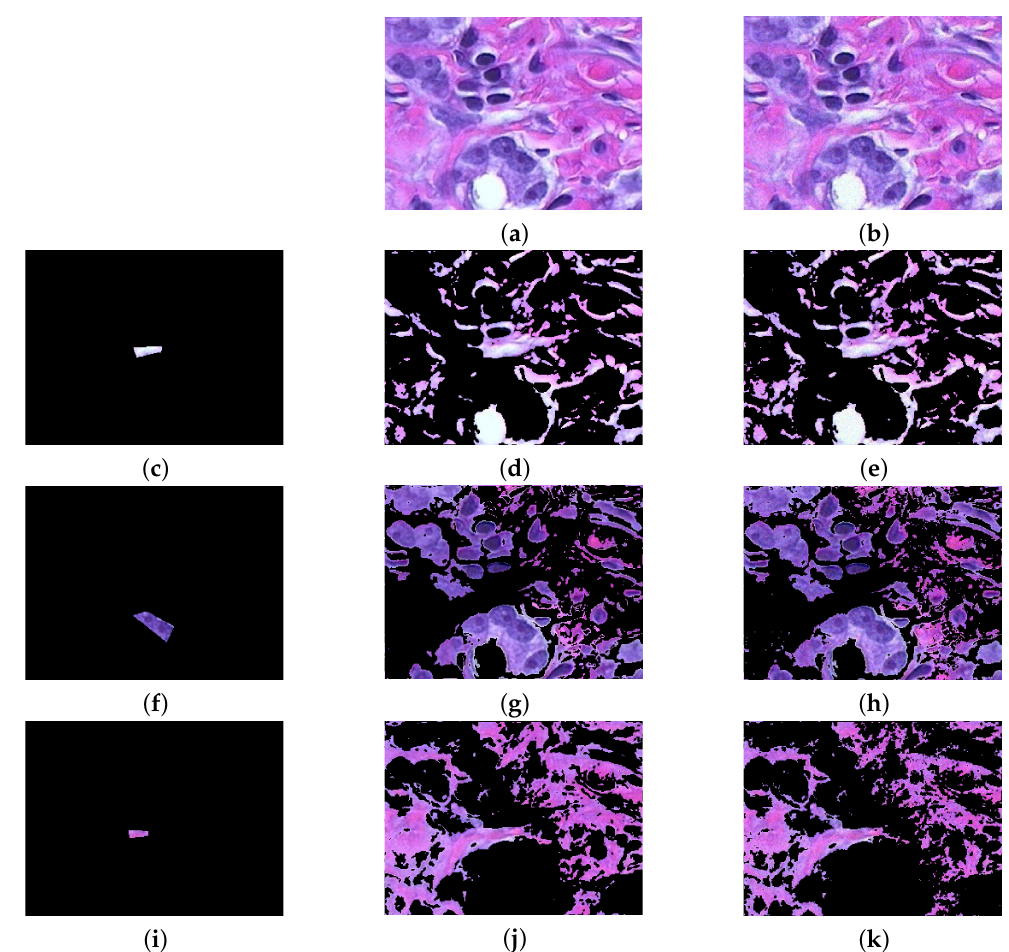
Figure 12. Matlab’s hestain image. ( a ) original image. ( b ) image affected by Poisson noise. ( c ) marked white background region, ( d , e ) segmentation of the white background on clean and noisy image, respectively. ( f ) marked region of the nuclei, ( g , h ) segmentation of the blue nuclei on clean and noisy image, respectively. ( i ) marked pink background region, ( j , k ) segmentation of the pink background on clean and noisy image, respectively. The results are obtained with α = 1.2 for the clean image and with α = 1.5 for the noisy image, while β is set to 1 in both